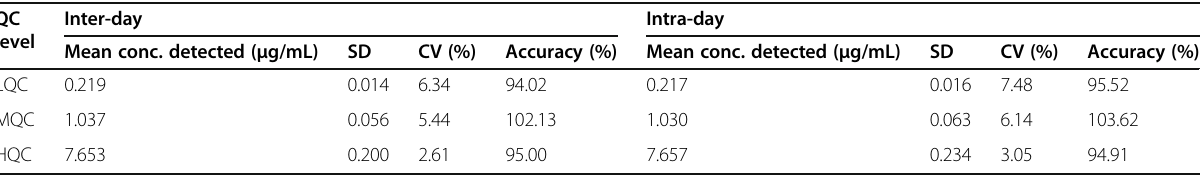
Table 1 Precision and accuracy data for the estimation of LTZ in rat plasma QC Inter-day Intra-day level Mean conc. detected ( μ